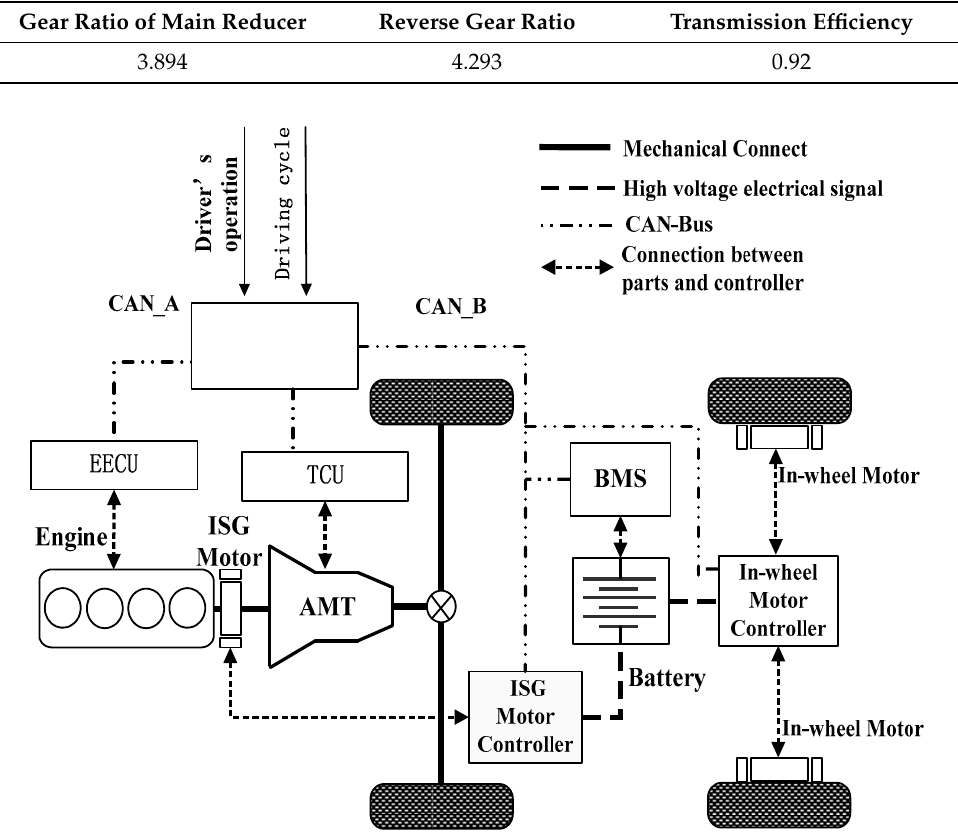
Figure 1. Powertrain structure of hybrid electric vehicle (HEV).